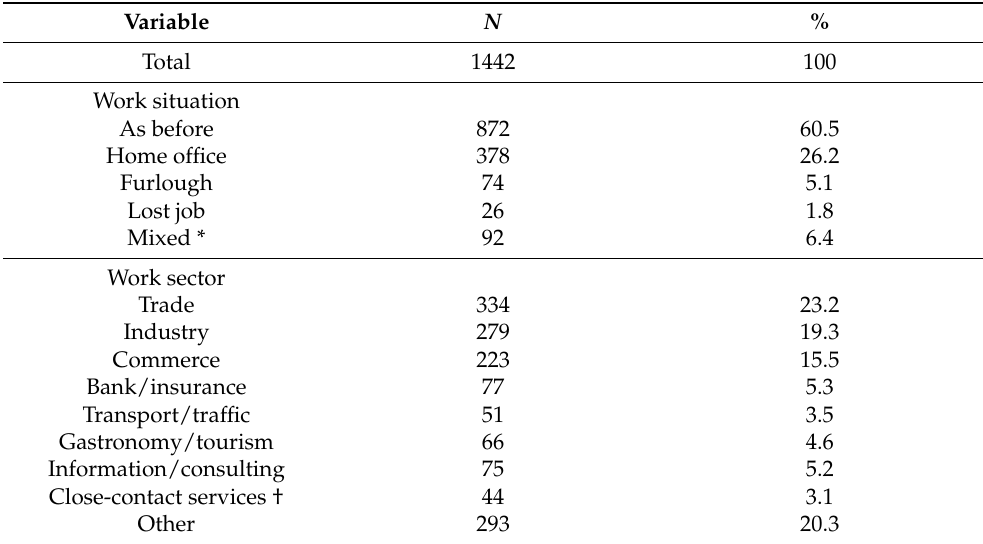
Table 1. Work situation and work sector characteristics of the study sample ( N = 1442).